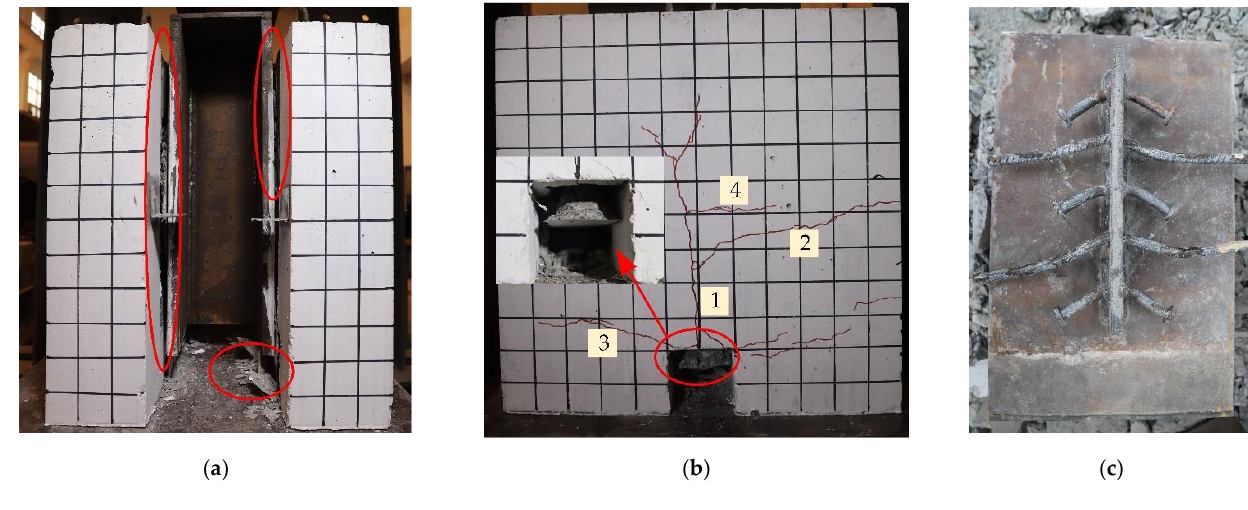
Figure 8. Failure modes of composite connectors without end-bearing concrete: ( a ) front of concrete slab; ( b ) side of concrete slab; ( c ) perforated steel plate.